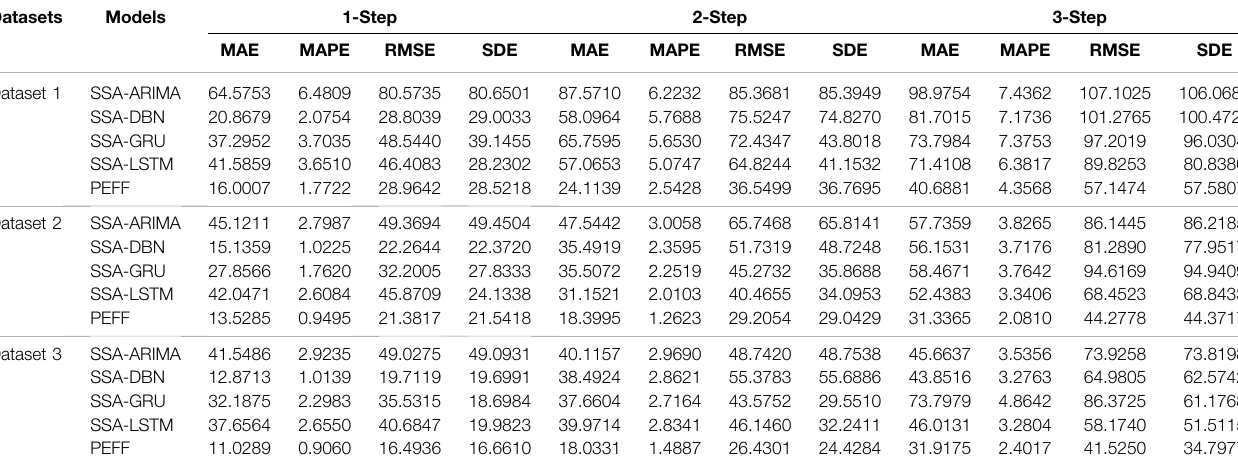
TABLE 4 | Comparison of the prediction performance of the PEFF and hybrid